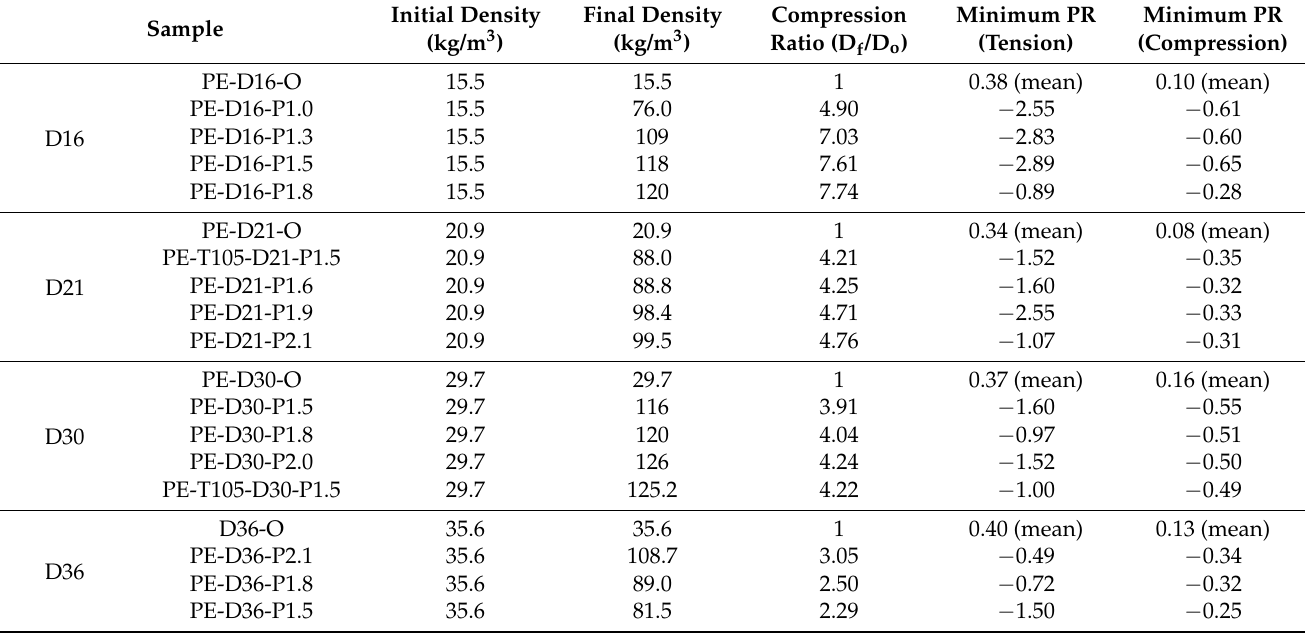
Table 3. Performance of auxetic LDPE foams.